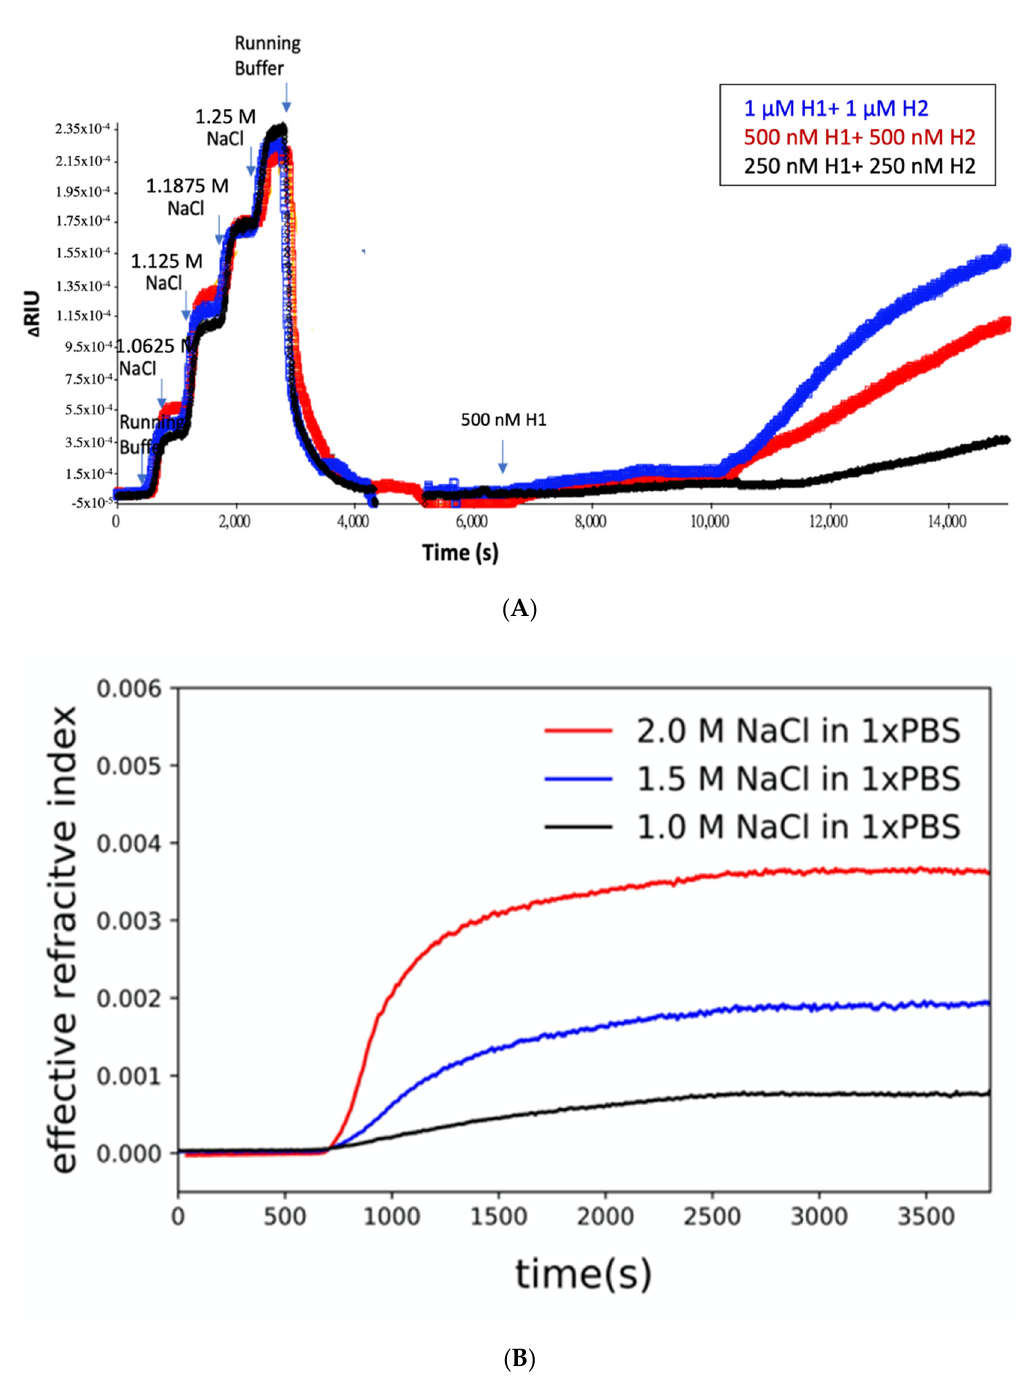
Figure 5. Result of HCR reaction under different aptamer concentrations and ionic strength environments. ( A ) The concentration of H1, H2 and the subsequent HCR amplification are in direct proportion: while the concentration of H1 and H2 increases, HCR amplification increases. Blue: 1 µ M H1+ 1 µ M H2, Red: 500 nM H1 + 500 nM H2 and Black: 250 nM H1 + 250 nM H2. ( B ) Validation of salt concentration of HCR on pSPR with pre-immobilized initiator probe; 1.0 M, 1.5 M and 2.0 M NaCl in 1 × PBS were added with 1 µ M H1 and H2 mixture at 400 s, and injected 1 × PBS buffer at 2530 s. Three HCR reactions showed 0.0007, 0.0018 and 0.0036 in ∆ RIU indicating different salt concentrations affected HCR amplification